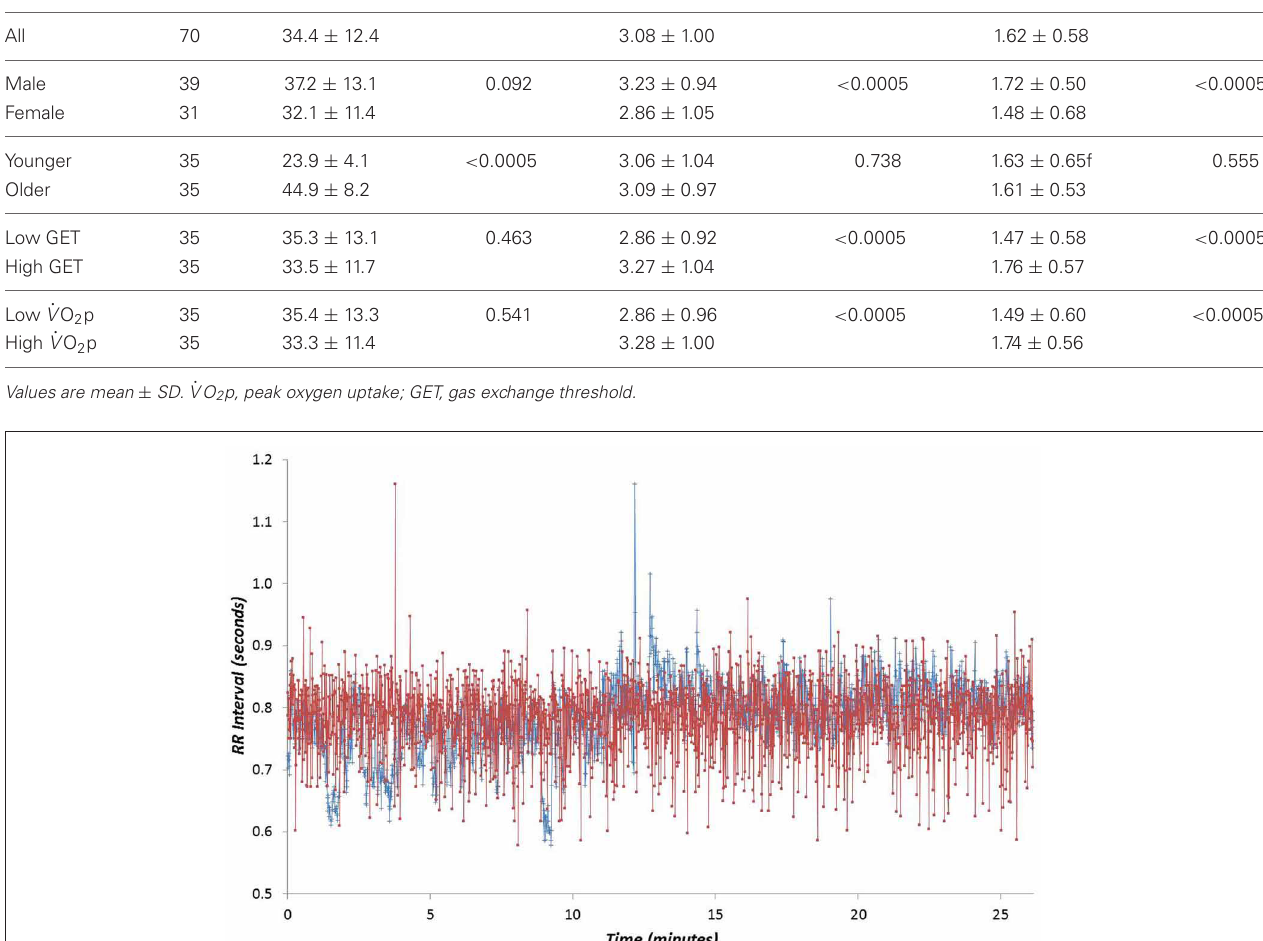
η 2 = 0 . 12) and FWHM ( p = 0 . 033, η 2 = 0 . 08), we note that the vast majority of females (27 out of 31) were in the lower